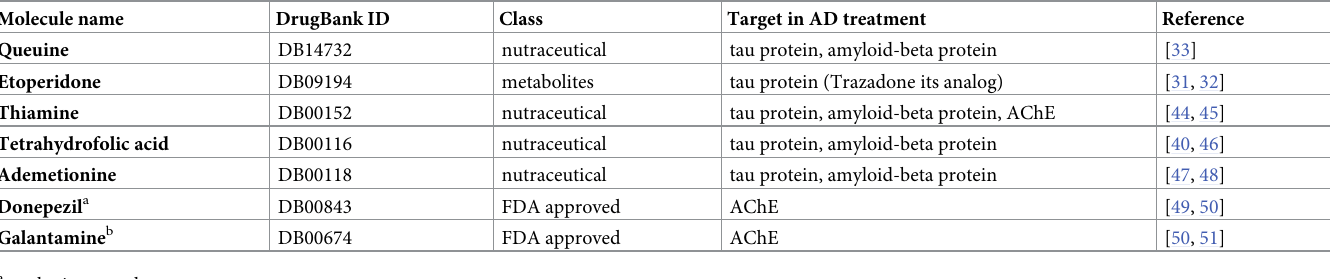
Table 1. Molecular properties of hit natural molecules compared to FDA approved AChE